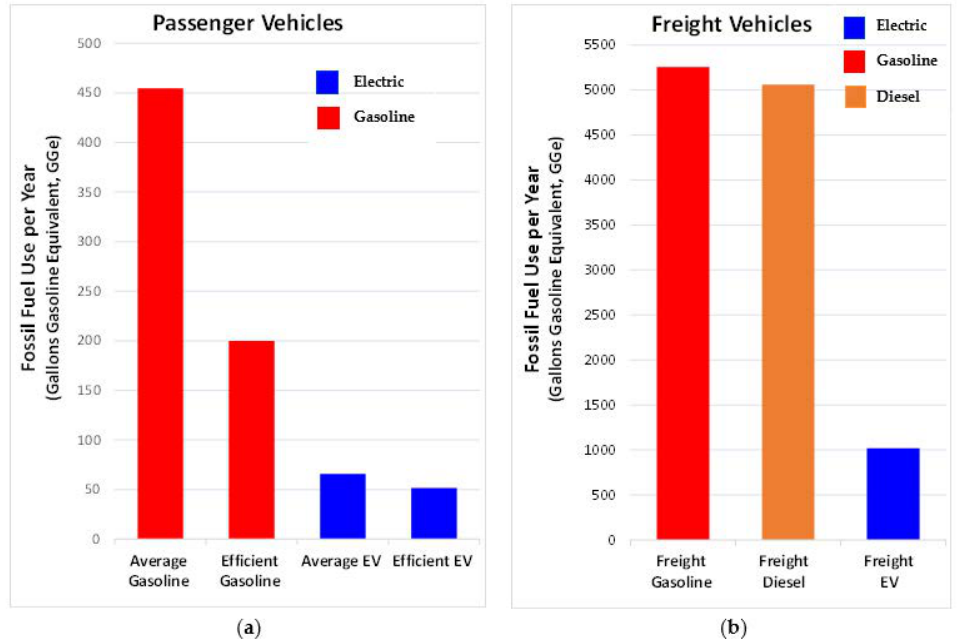
Figure 3. Comparison of fossil fuel consumption on Oahu in 2020, for Internal Combustion Engine (ICE) vehicles and EVs (gallons of gasoline equivalent, GGe): ( a ) Average and efficient passenger vehicles; ( b ) Average freight